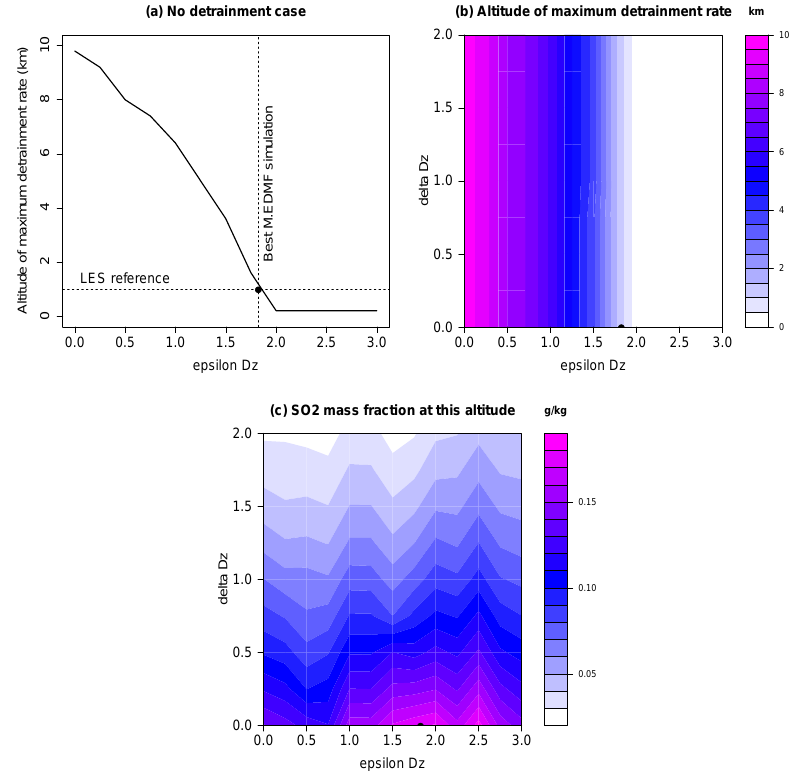
Figure 8. Sensitivity of plume characteristics to various entrainment ( ε ) and detrainment ( δ ) values prescribed for the first model level (within (cid:49)z = 40ma.g.l.). An ensemble of 13 × 9 SCM simulations was considered to build these graphs, with dimensionless values of ε(cid:49)z ranging from 0 to 3, and for δ(cid:49)z from 0 to 2 (by 0.25 steps in both cases). (a) δ = 0 case: altitude where the maximum SO 2 mass detrainment rate is found as function of ε(cid:49)z . The horizontal dashed line is the maximum injection height (1.0km) found in the reference LES. (b) Contour plot showing the altitude where the maximum SO 2 mass detrainment rate is found as function of both ε(cid:49)z and δ(cid:49)z . (c) Contour plot of SO 2 mass fraction in ambient air in the grid cell at this altitude. In all panels, the black dot marks the location in the ε – δ space of the best-fitted SCM simulation with respect to the reference LES simulation (see text for